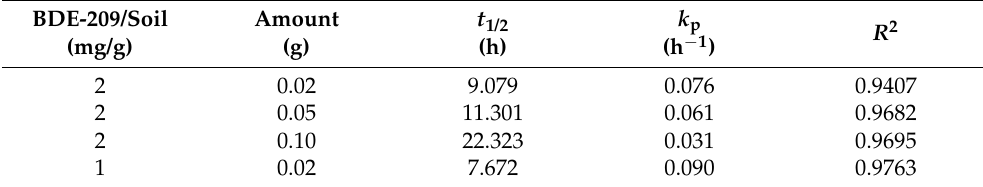
Table 3. BDE-209 photolysis kinetic parameters under different initial concentrations.